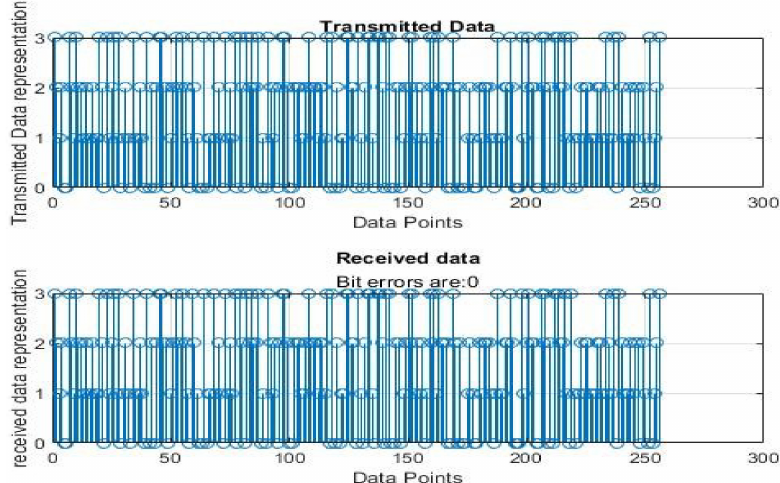
Figure 6. GAWDO QPSK output for 256 data points in a noiseless